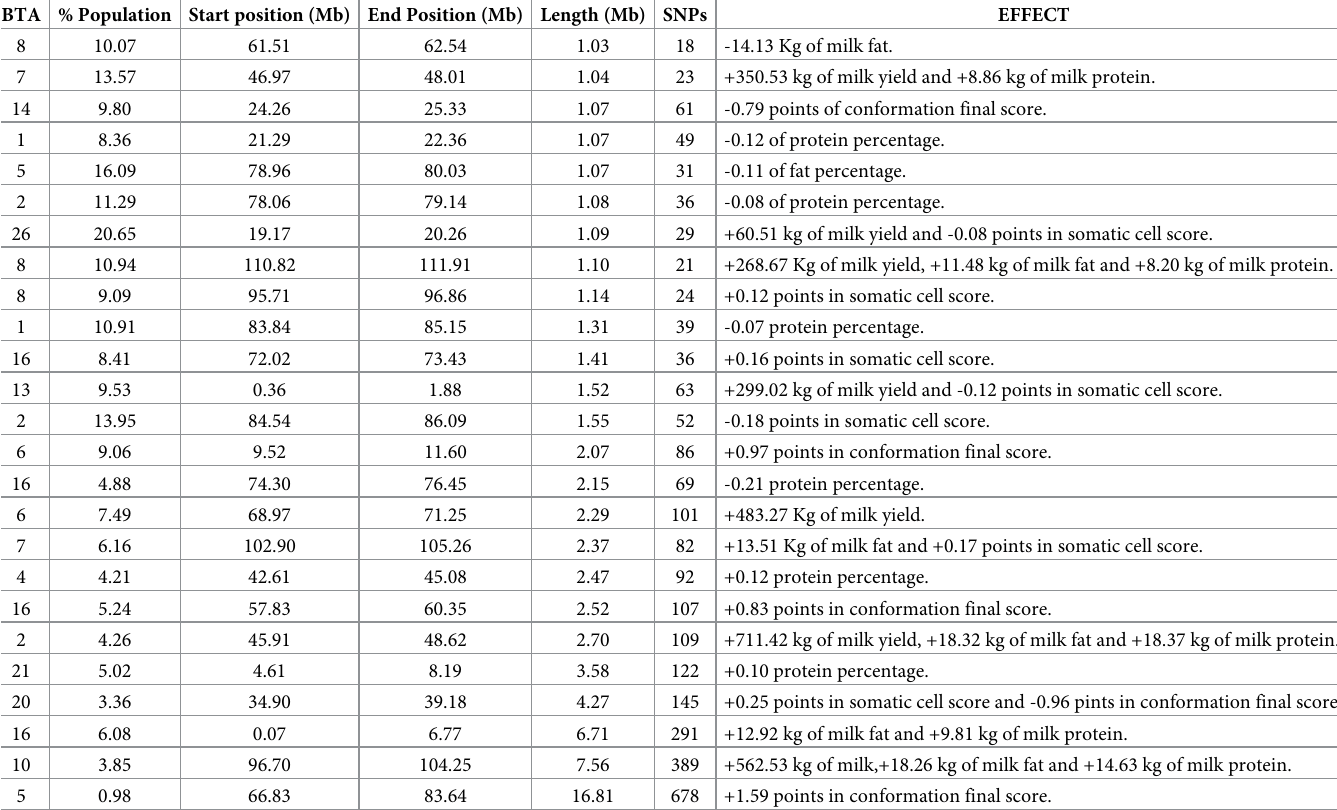
Table 3. Effect of ROH on productive traits; milk, fat, protein, somatic cell score and conformation final